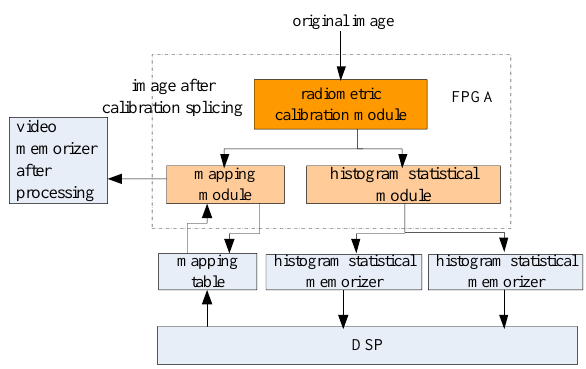
Figure 3. Structure diagram of calibration system for HiRISE imagery